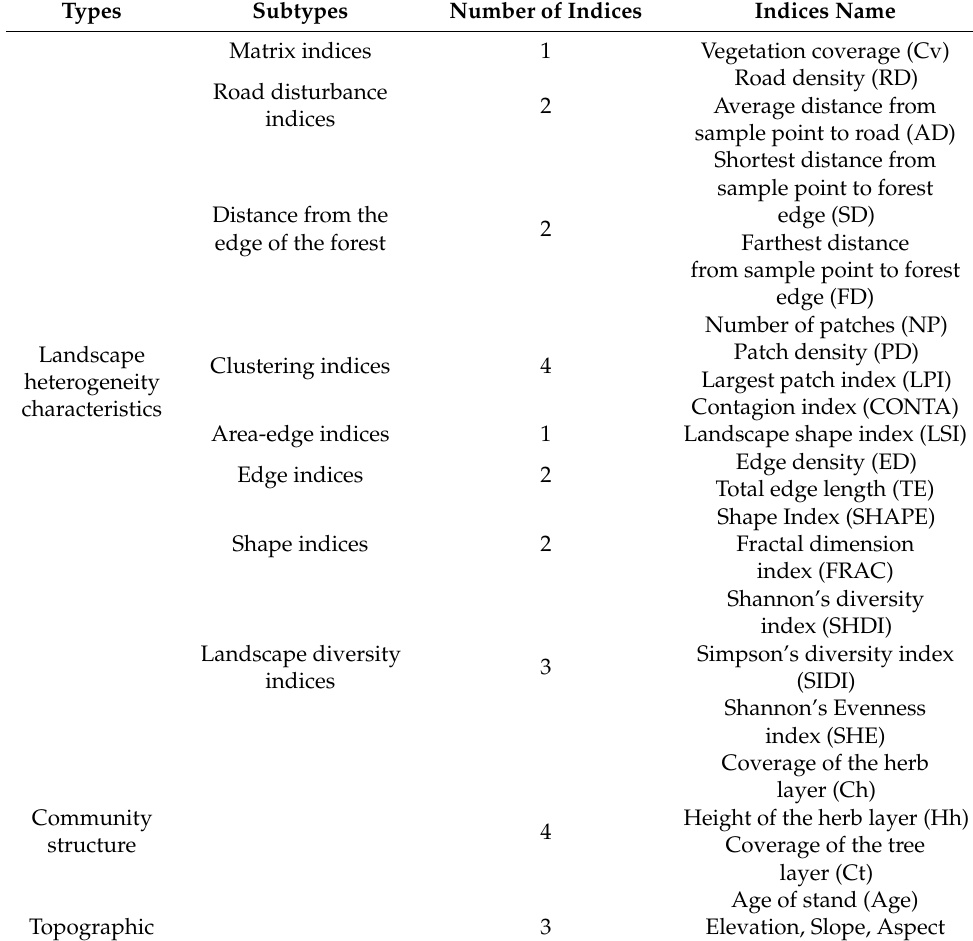
Table 2. The selection indices of landscape heterogeneity, community structure, and topographical